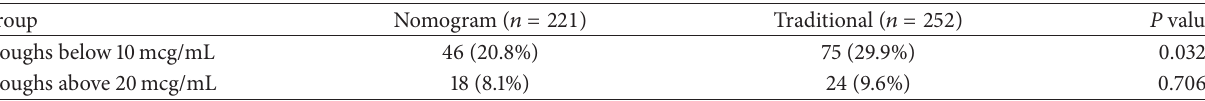
Table 2: Occurrence of troughs less than 10mcg/mL and above 20 mcg/mL.